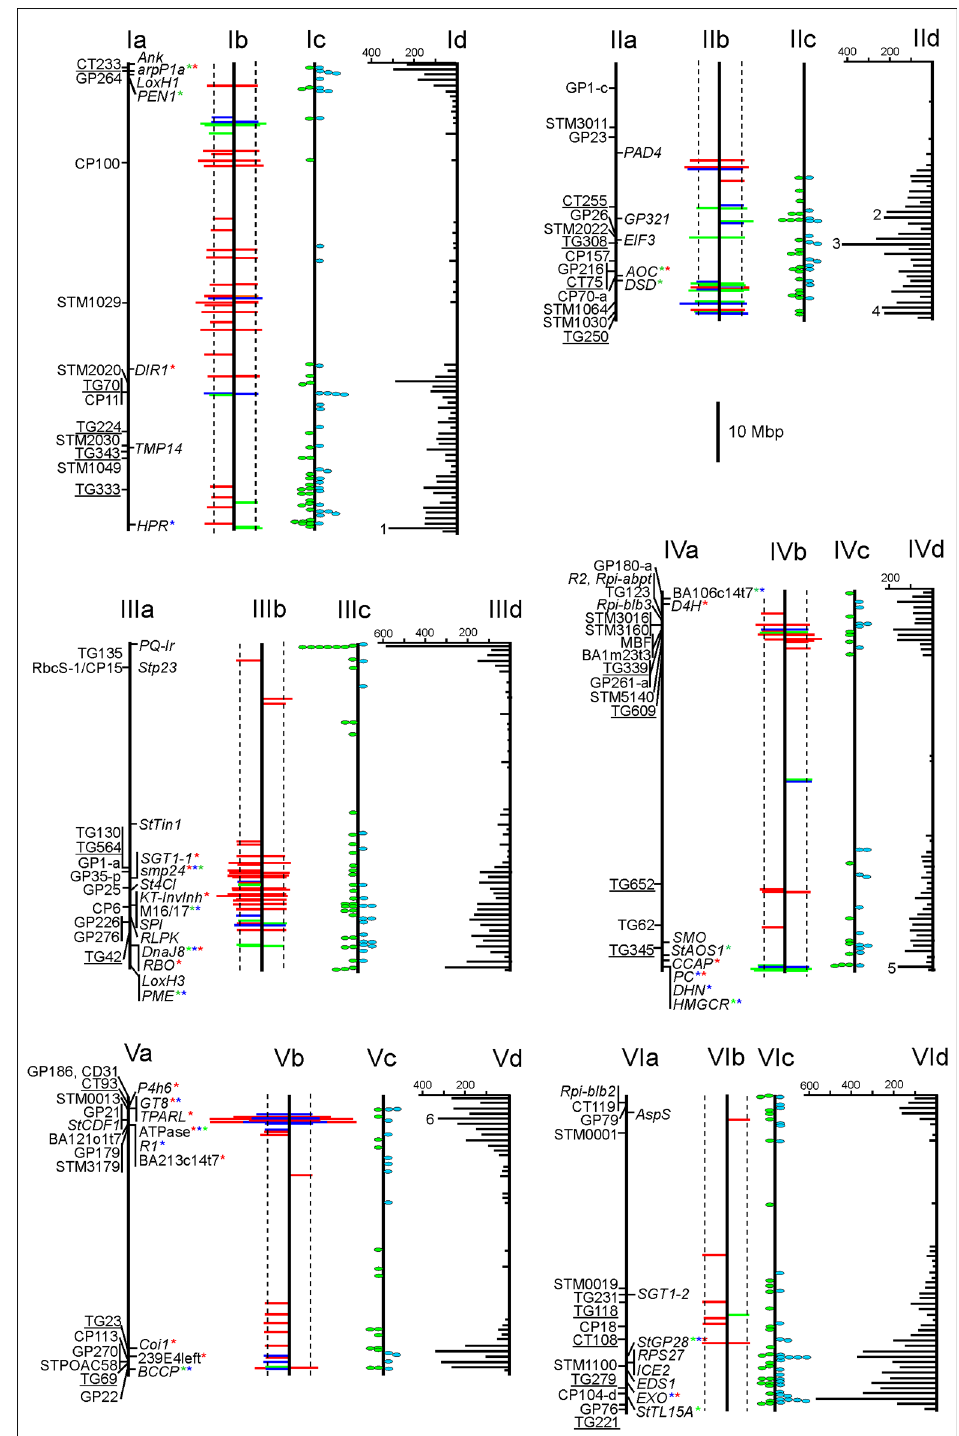
Fig 1. Physical maps of the potato chromosomes I to VI (pseudomolecules v4.03). Maps ‘ a ’ show to the left of the central bar (representing the chromosome) the positions of markers that were previously shown to be linked with P . infestans QRL in potato and the highly syntenic tomato ( Solanum lycopersicum ). Markers linked to P . infestans QRL in tomato are underlined (for physical positions and references see S8 File). The candidate loci tested for association with MCR, rAUDPC and PM in the PIN184 population previously [5,